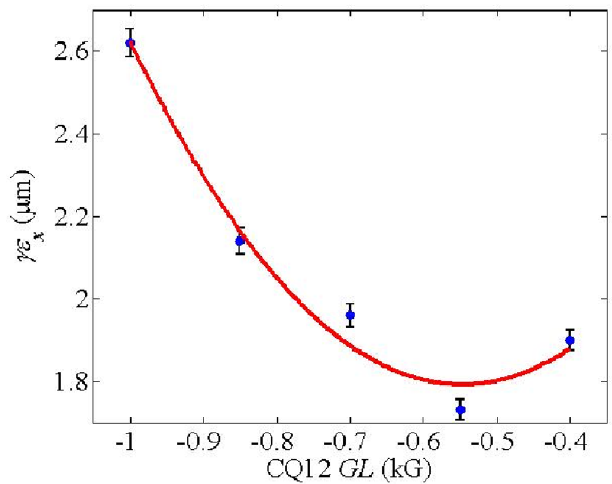
FIG. 39. (Color) Horizontal emittance at 250 MeV on OTR screen after the BC1 chicane, with nominal rf phasing, optimized by varying the length-integrated field gradient, GL, of the second BC1 dispersion quadrupole, CQ12 . The emittance upstream of the BC1 was about 1 : 2 (cid:2) m